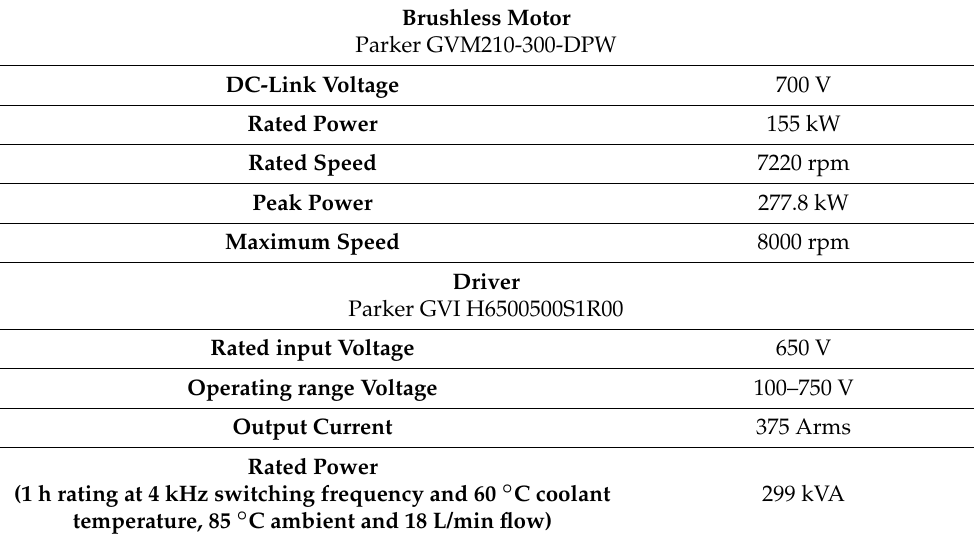
Table 1. The main data of the brushless motor and